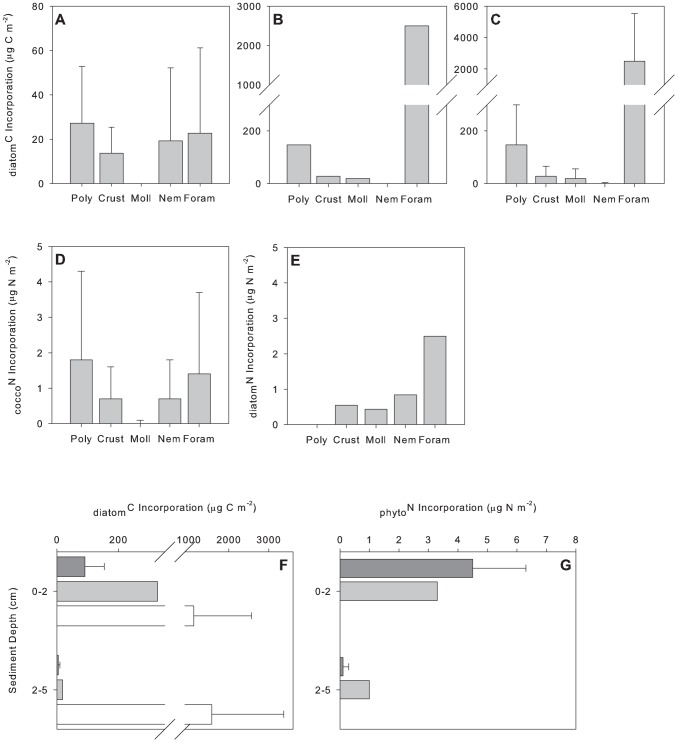
Mean incorporation µg C m−2 or µg N m−2 (±1 standard deviation) of (a) diatomC from Exp. 1 in June; (b) diatomC from Exp. 2 in June; (c) diatomC from September; (d) coccoN from Exp. 1; (e) diatomN from Exp. 2.Vertical distribution of (f) phytoC and (g) phytoN. In plots f and g, dark grey bars represent incorporation from Exp. 1, light grey bars represent incorporation from Exp. 2 and white bars represent mean incorporation of tracer from September. Note the data presented from Exp. 2 in June represents total incorporation µg C m−2 or µg N m−2. Number of replicates in Exp. 1 = 3 and Exp. 2 = 1 and September  = 3.